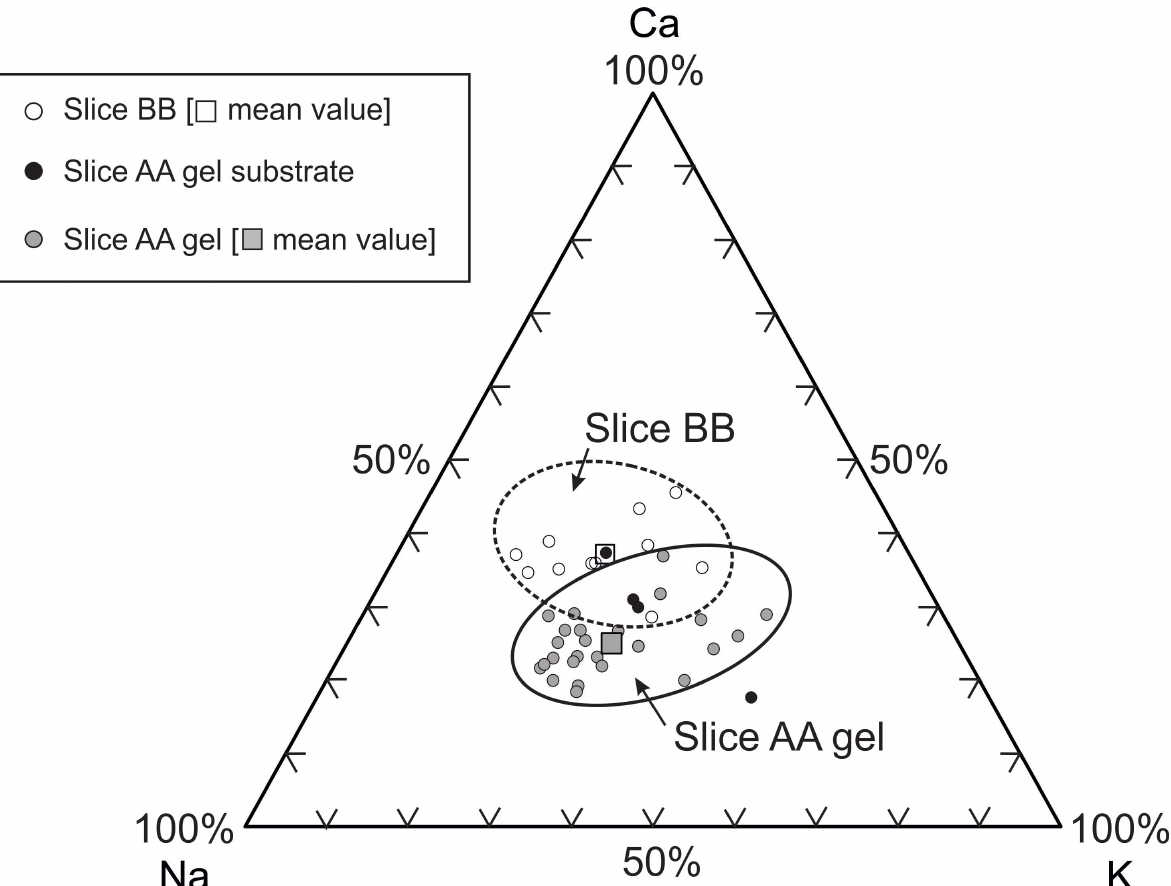
Figure 8. Molar ratio triplot for Ca-Na-K from EDXA. The EDXA illustrates the compositional variations of the hydrous gel and gel substrate (slice 1 piece AA) and background bentonite matrix (slice 2 piece BB). Note: these data have been corrected to allow for the potential contribution of Ca from the presence of minor amounts of gypsum detected during